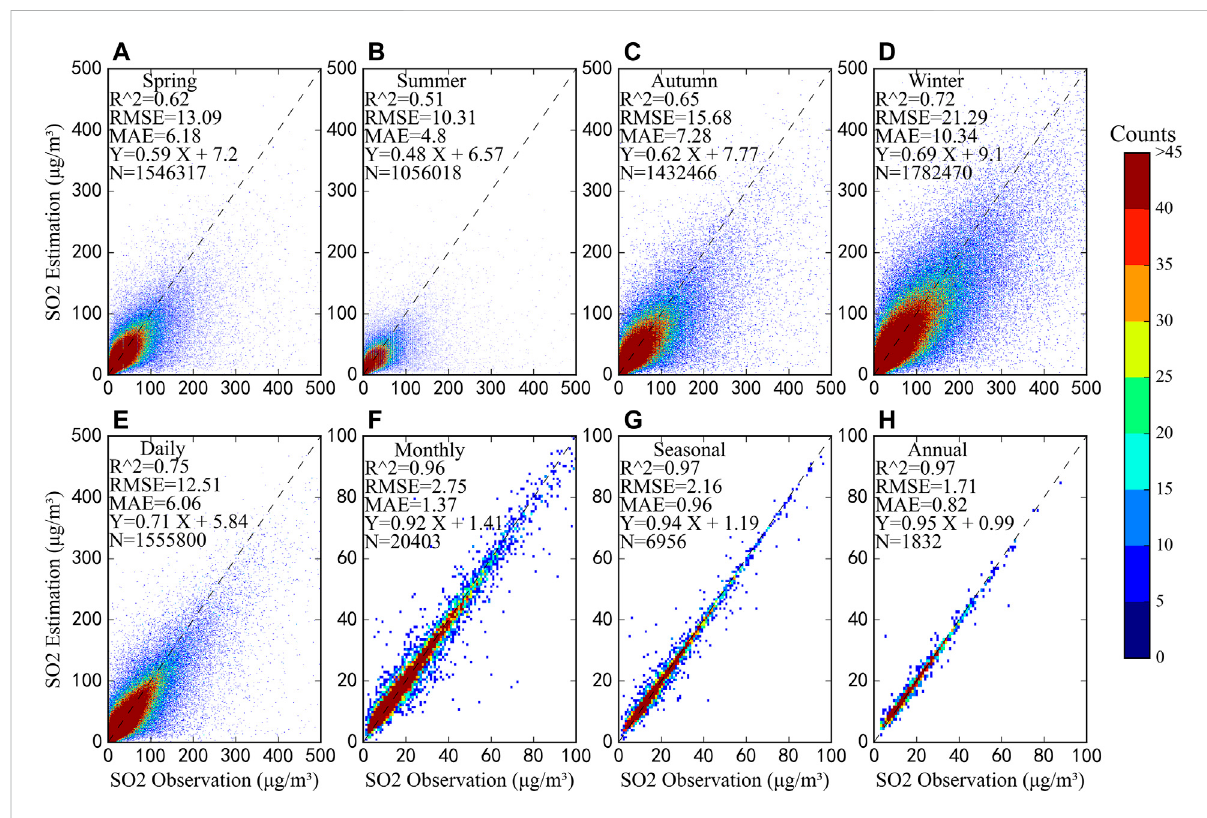
FIGURE 4 SimilartoFigure3,exceptforspring (A) summer (B) autumn (C) winter (D) daily (E) monthly (F) seasonal (G) andannual (H) average10-foldcross validation results of Himawari-8 TOAR-SO 2 model based on